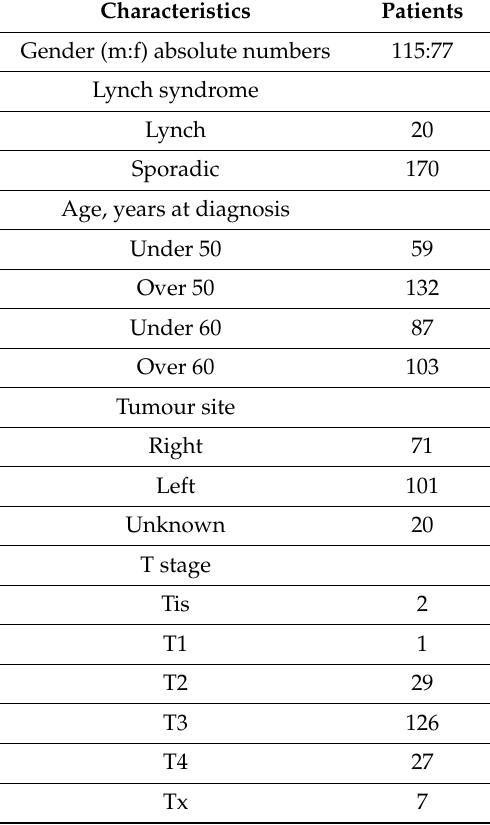
Table 3. Clinical data for the patients and biopsies used in the miRNA validations. Data regarding age, gender, tumour site, T-stage, N-stage, M-stage and staging according to AJCC 7th edition are